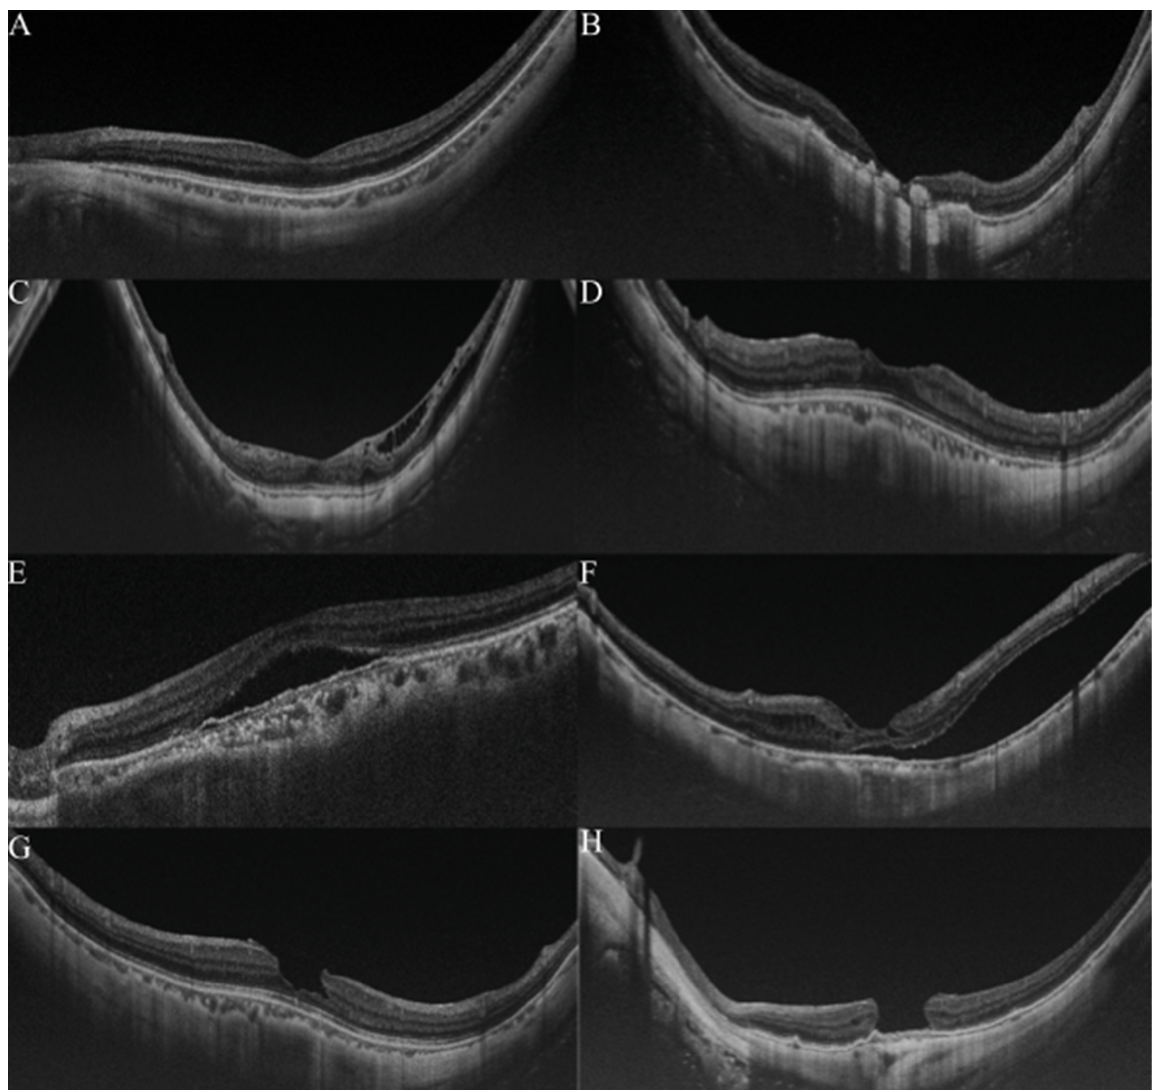
Figure 3. Grading samples of myopic maculopathy in ocular coherence tomographic (OCT) images. ( A ). Myopic eye without myopic maculopathy. Each of retinochoroidal layer is clearly seen. ( B ). Myopic neovascularization (MNV). Hyperreflective materials can be seen above the retina pigment epithelium (RPE), and this component is attenuated in the tissue coherence signals below. ( C ). Retinoschisis. The splitting of the inner retina from the outer retinal layers with multiple perpendicularly aligned columnar structures connecting the split retinal layers. ( D ). Dome-shaped macular (DSM). An inward bulging of the retina pigment epithelium above the baseline connecting the RPE lines on both sides away from the DSM. ( E , F ). Retinal detachment. The neurosensory retina is detached from the RPE. ( G , H ) Macular hole. A tear above the RPE layer and an anvil-shaped deformity of the cracked edges of the retina. Reprinted from Validation of Soft Labels in Developing Deep Learning Algorithms for Detecting Lesions of Myopic Maculopathy from Optical Coherence Tomographic Images , Copyright (2021), with permission from Wolters Kluwer Health.